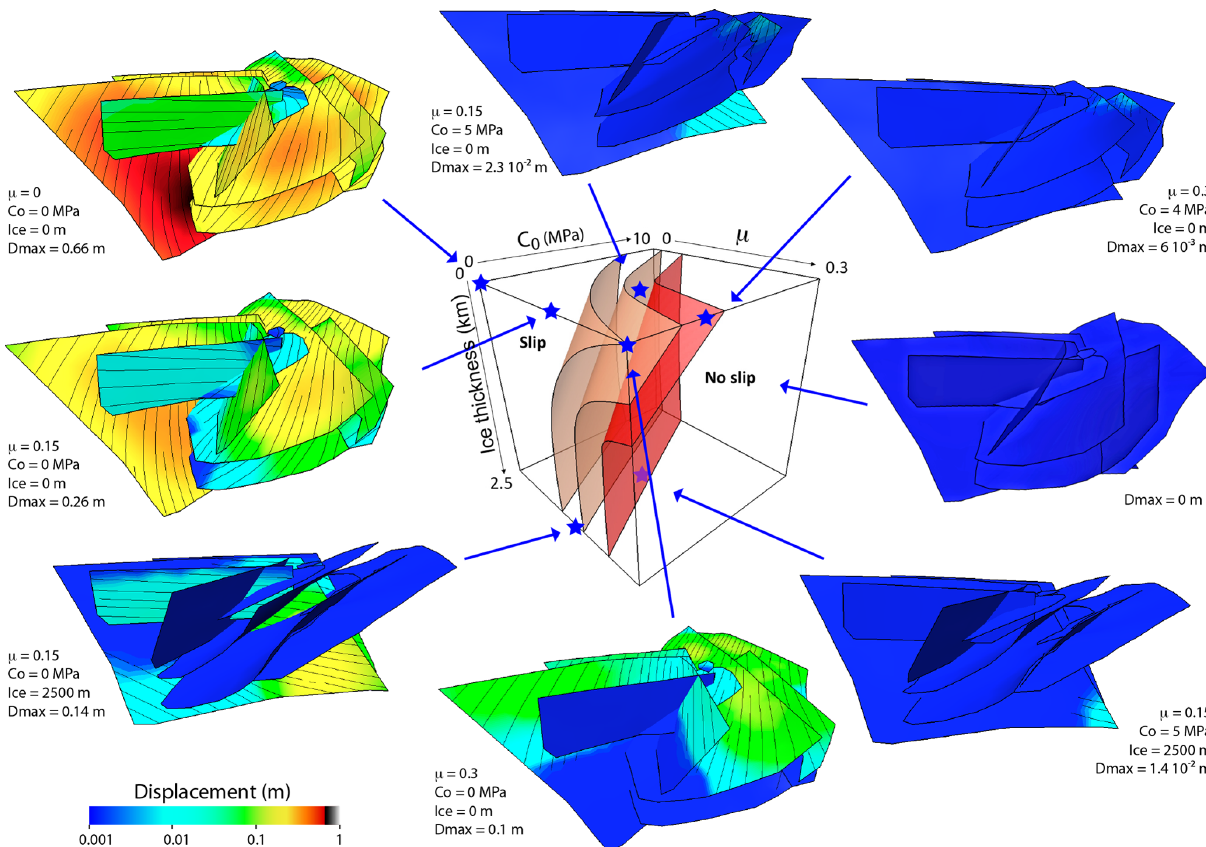
Figure 7. Examples of 3-D quasi-static fault displacement distribution on the Olkiluoto model for different loading and fault property conditions indicated on the fault slip diagram by blue stars. Streamlines on fault surfaces are slickenlines. The color bar scale for displacement is